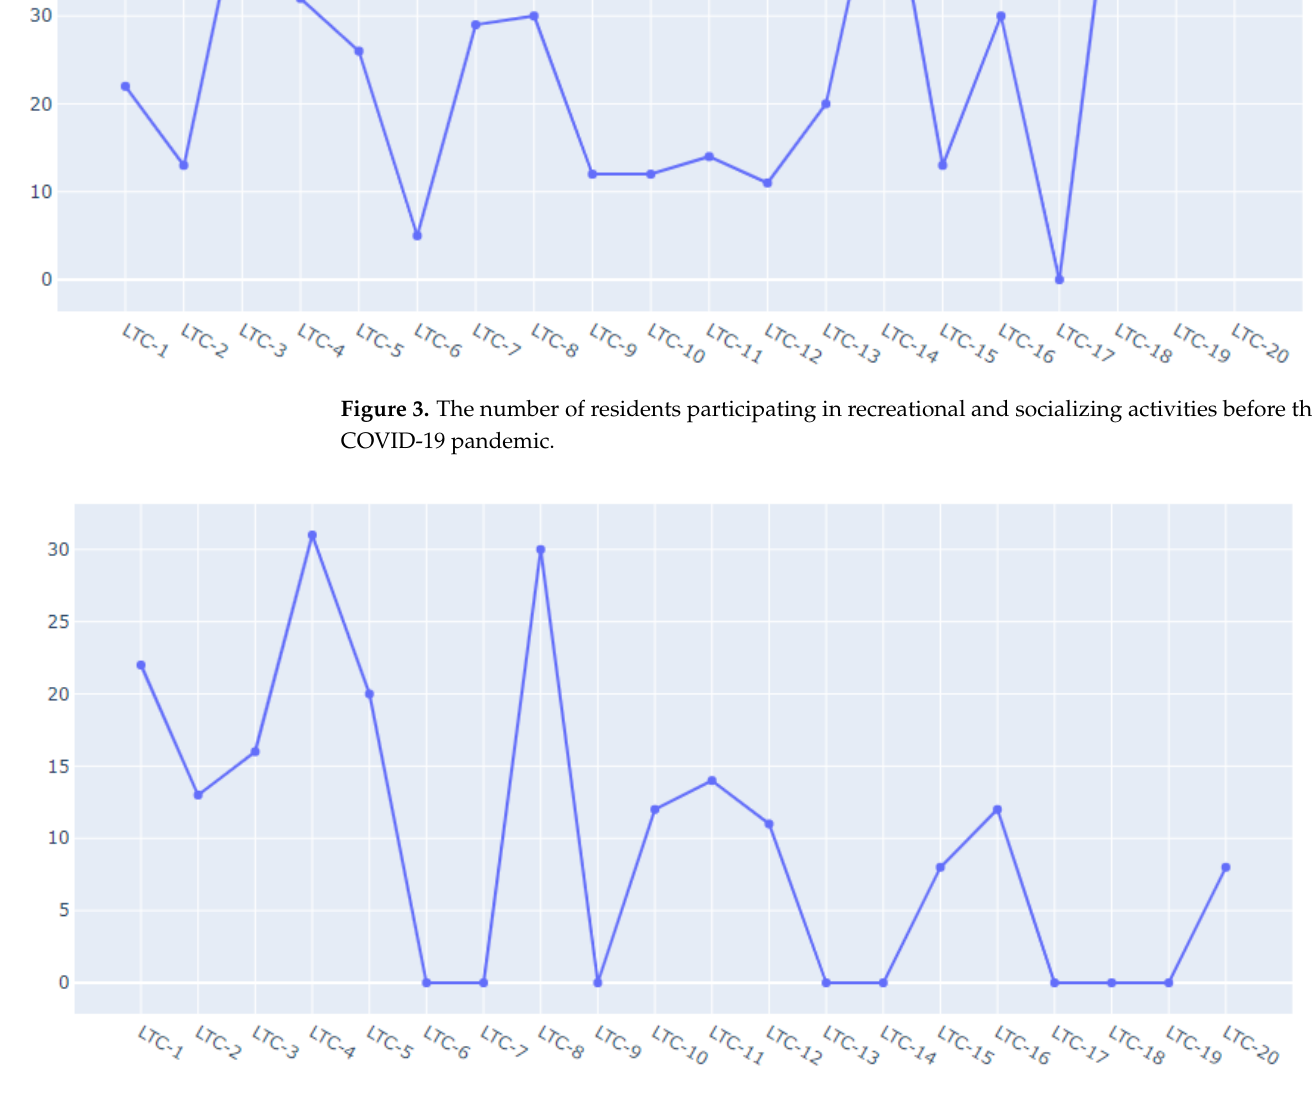
Figure 4. The number of residents participating in recreational and socializing activities after the COVID-19 pandemic.